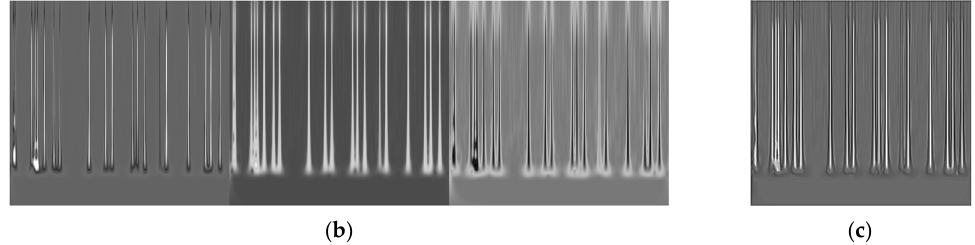
Figure 10. Features learned from the heart sound biometric: ( a ) a sample input image, which is an output of the heart sound signal processing pipeline; ( b ) the features extracted from the first convolutional layer; ( c ) the strongest feature in the third convolutional layer. White pixels represent strong positive activations and black pixels represent strong negative activations.